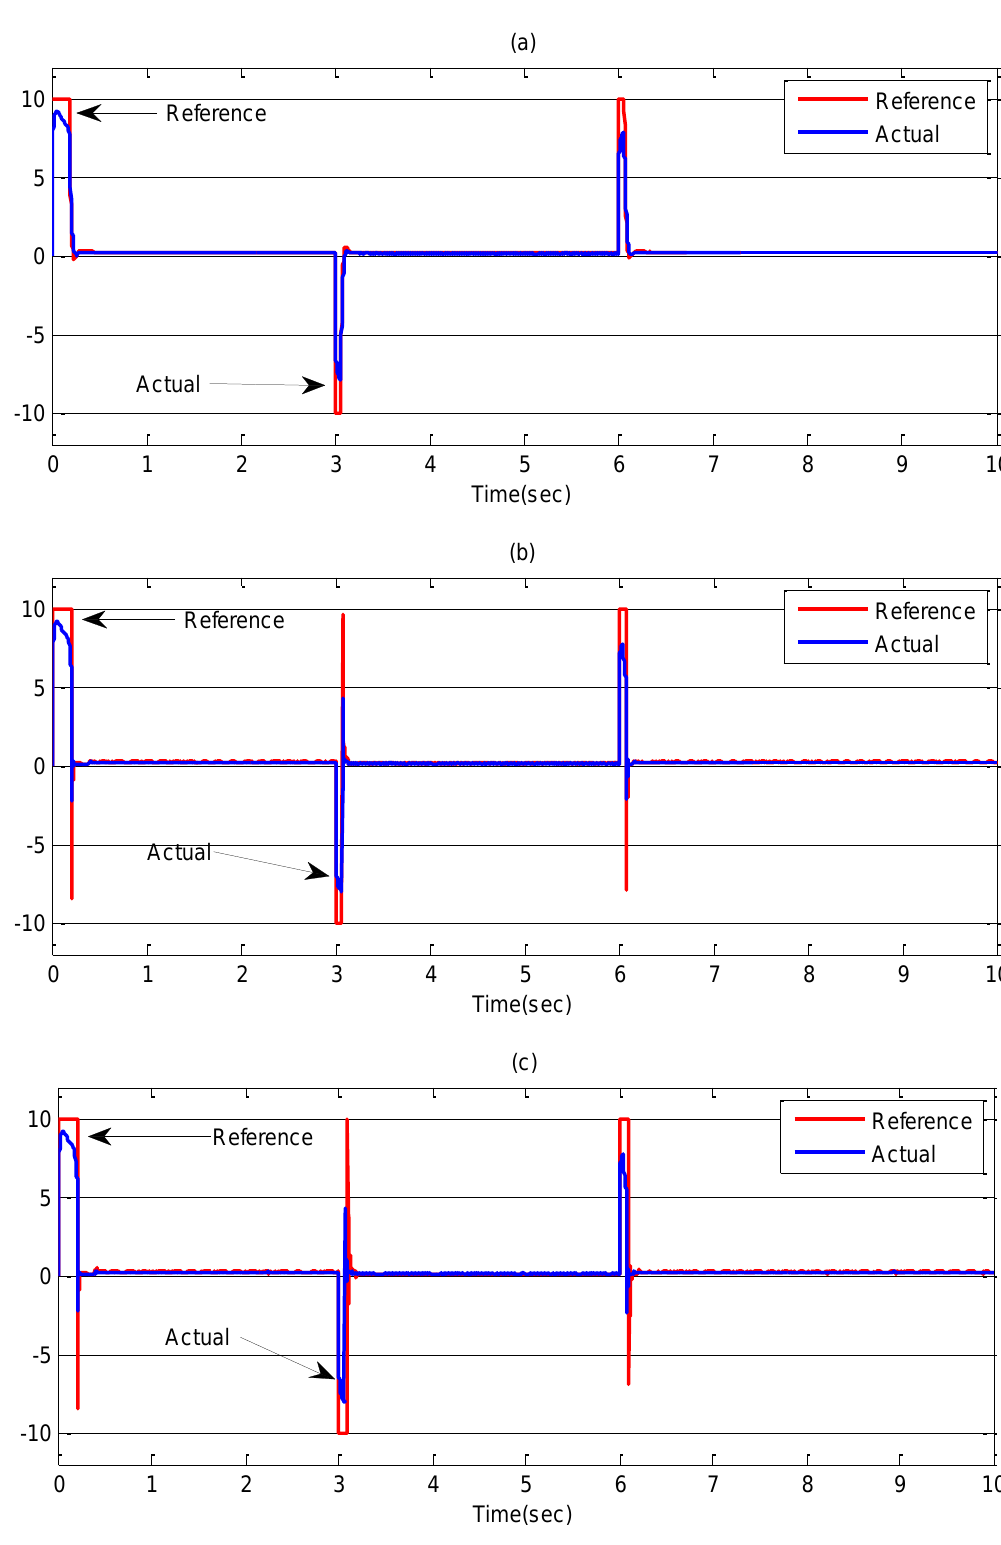
Figure 8. Simulated q-axis current responses-based IM drive at no load in Case-1 ; ( a ) the tuned PI controller, ( b ) the conventional BLFC controller, and ( c ) the proposed NBLFC